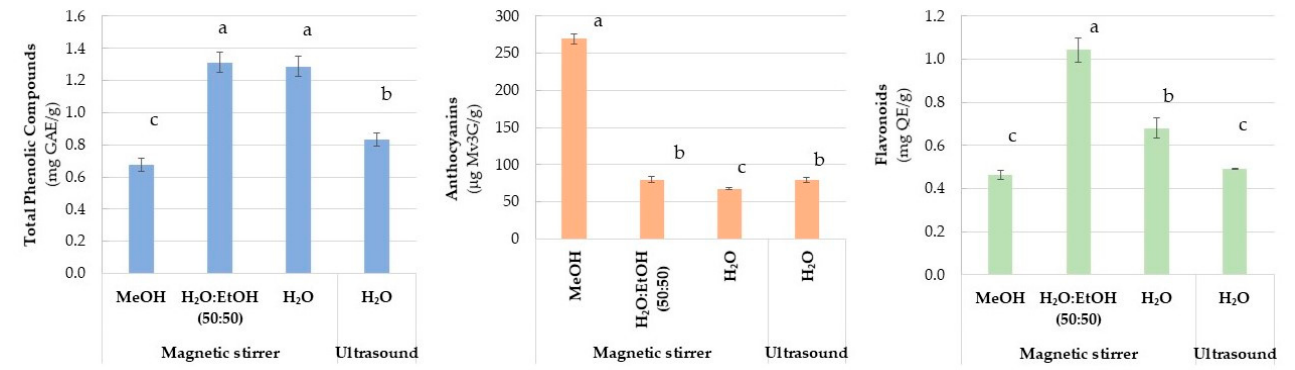
Figure 2. Content of total phenolic compounds, anthocyanins and flavonoids in the extracts obtained in the preliminary assay. Bars with the same letter are not statistically different (ANOVA with Tukey post hoc test, level of significance p < 0.05).